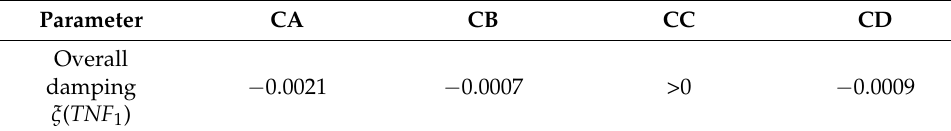
Table 5. SSD Overall damping ξ ( TNF 1